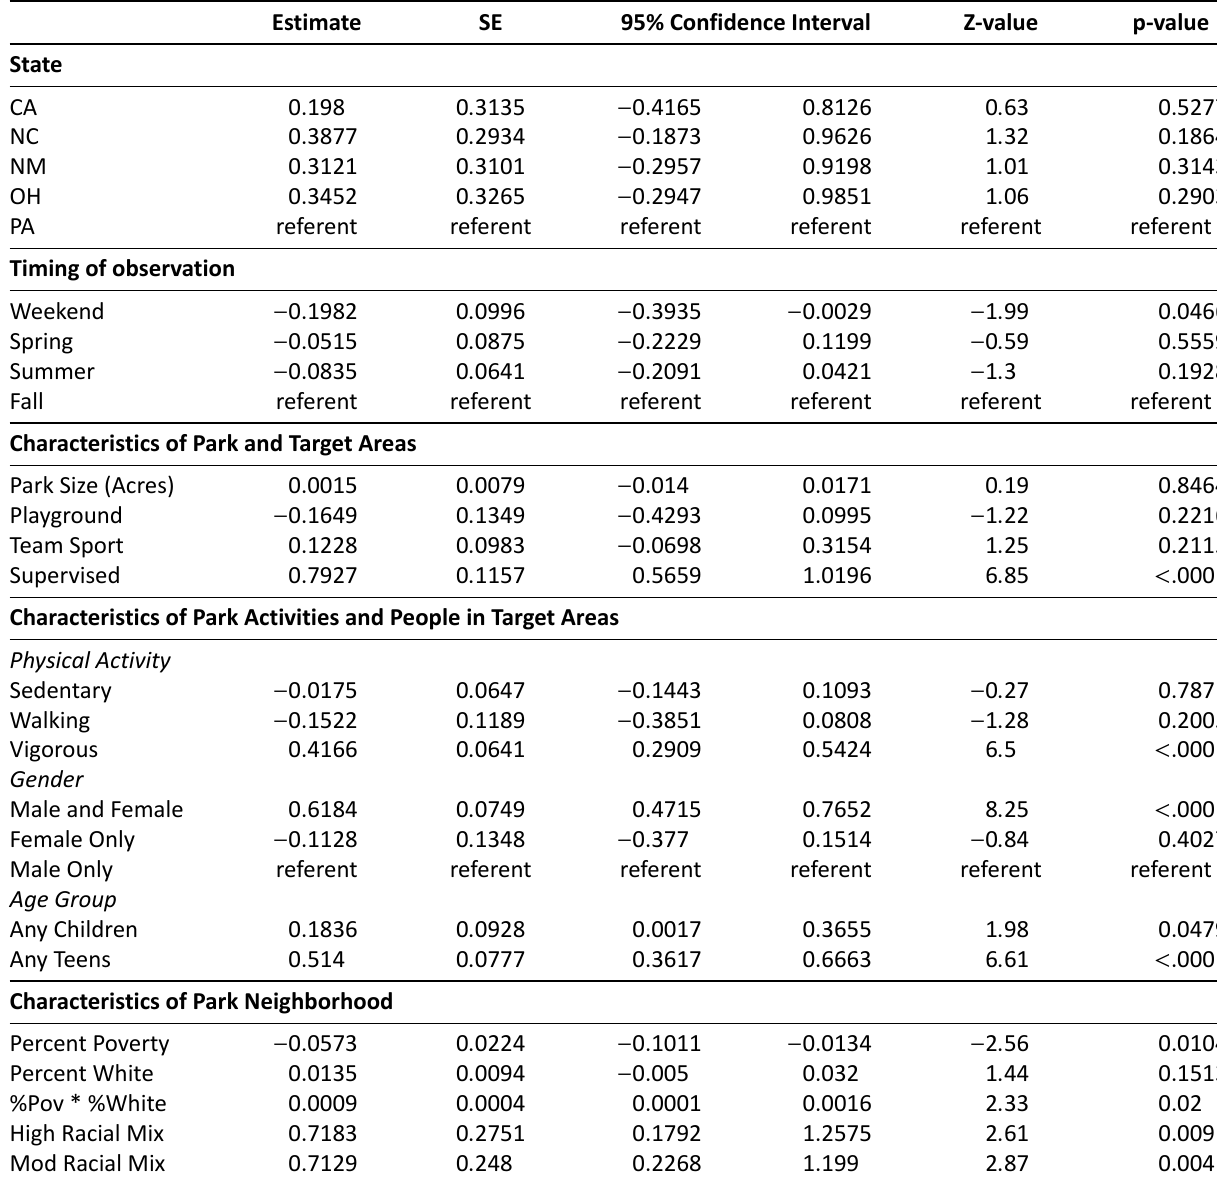
Table 3. Analysis of GEE parameter estimates for interracial